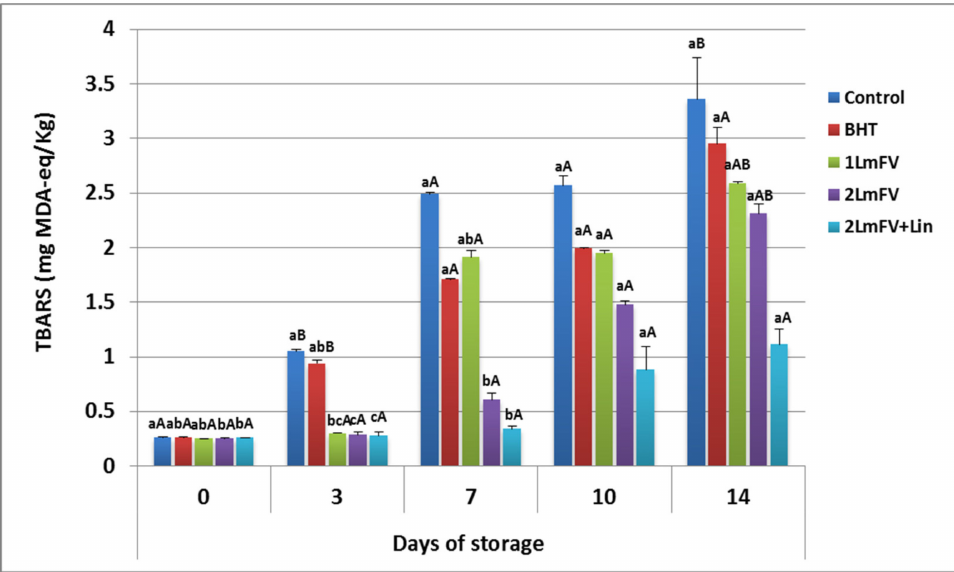
Figure 4. TBARS (mg MDA-eq/Kg) values for raw minced beef stored at 4 ◦ C for 14 days; means ± SEMs (n = 3). Values with a different letter (a–c) for the same storage day are significantly different ( p < 0.05). Values with a different letter (A,B) for the same concentration are significantly